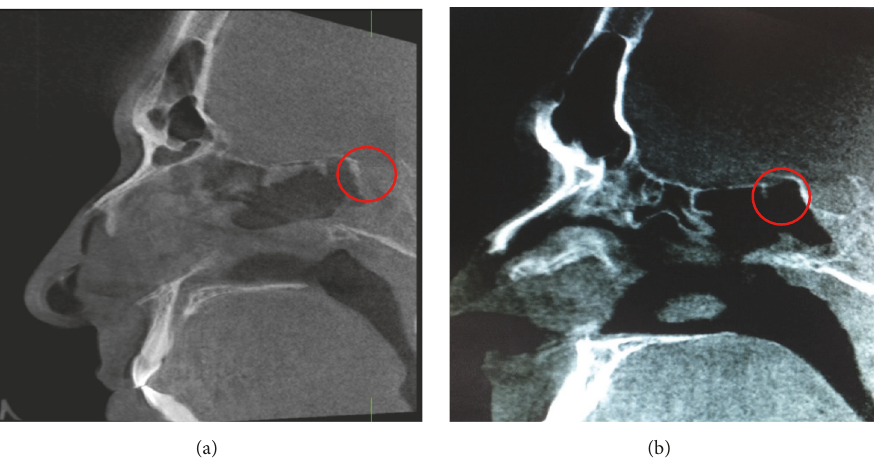
Figure 8: Case 5. (a) Preoperative CT scan showing a CSF leak in the anterior wall of the sella turcica. (b) Three-month postoperative CT showing a less dense bony closure of the surgical defect of the anterior wall of the sella